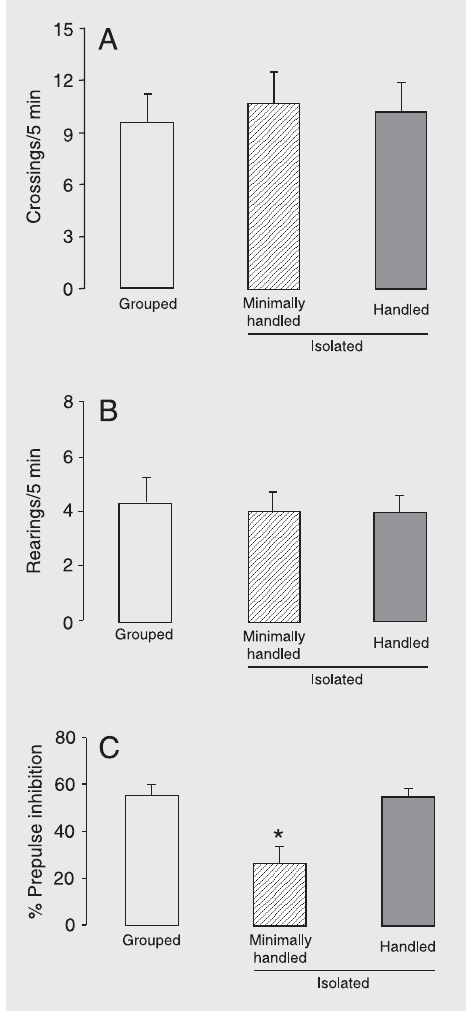
Figure 1. A , B , Exploratory activ- ity measured in the open field. Data are reported as mean ± SEM number of crossings (hori- zontal exploration, A) or rearings (vertical exploration, B). C , Per- cent of prepulse inhibition. N = 13 for grouped rats, N = 11 for minimally handled-isolated rats, and N = 15 for handled isolated rats. *P < 0.05 compared to both grouped and handled-isolated groups (one-way ANOVA fol- lowed by the Newman-Keuls